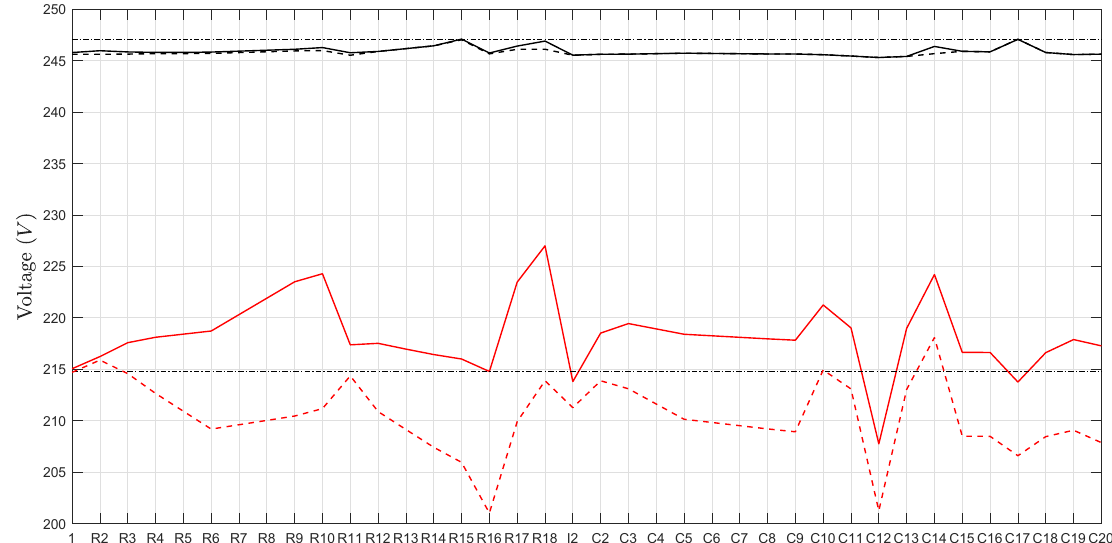
Figure 14. Maximum and minimum phase-neutral voltage at every bus for both the 1P-OLTCTS and 3P-OLTCTS (dashed